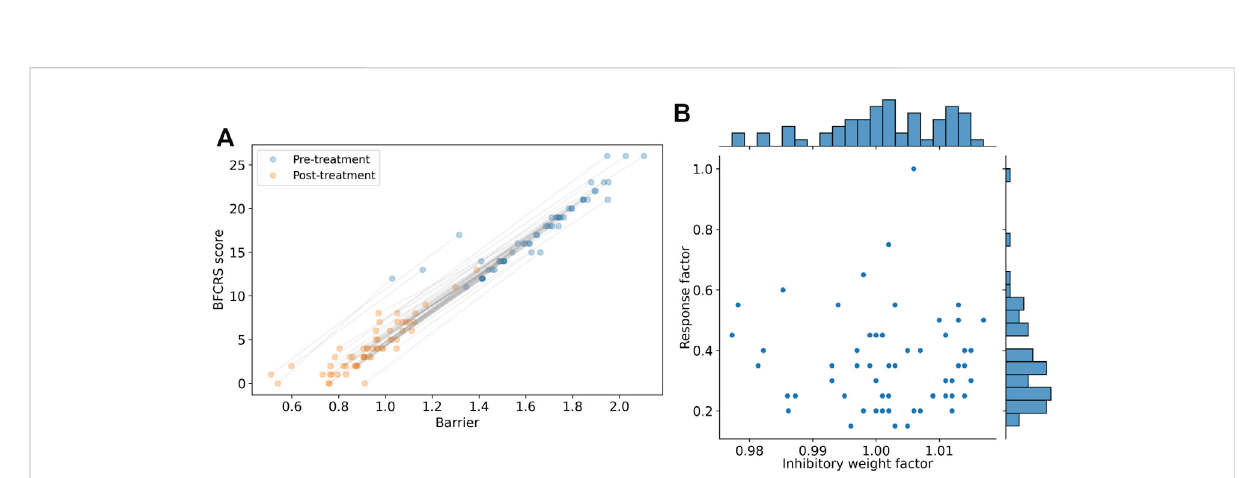
FIGURE 7 Demonstration ofpersonalizationpotential of themodel for individualized clinical predictions. (A) Personalized model prediction ofbarrierand the synthesized BFCRS score for subjects before and after treatment. The grey lines associate the pre- and post-treatment scores for the same subject. (B) Scatter plot and histograms of the parameters used for personalization (Inhibitory weight factor to modify w 00 and the medication response factor). The scatter plot reveals no signi fi cant correlation between the personalization parameters ( r 2 = 0.001 and p > 0 .